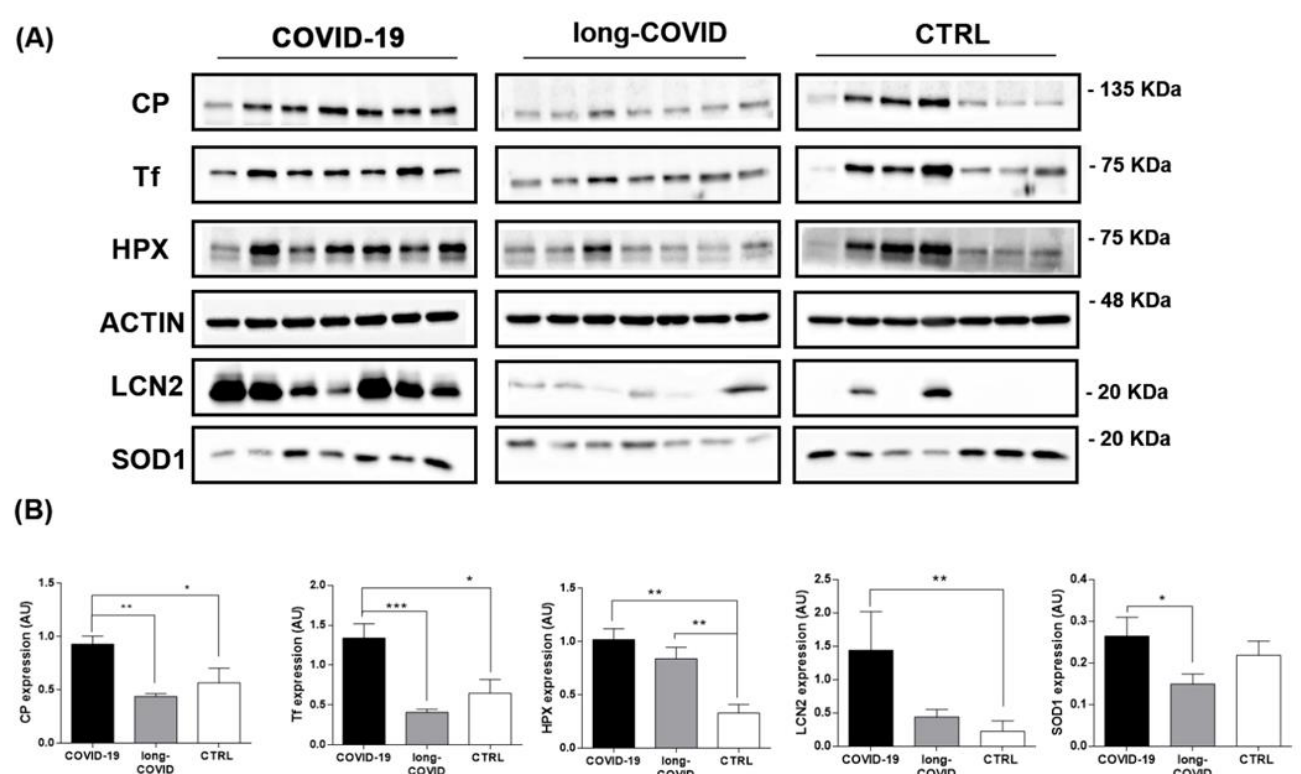
Figure 2. Western blot analysis for iron-related proteins in PBMCs isolated from COVID-19, long- COVID patients, and healthy controls. ( A ) Panels report the proteins levels for CP, Tf, HPX, LCN2, SOD1 and ACTIN in PBMCs isolated from COVID-19 patients (n = 7), long-COVID (n = 7) patients, and healthy volunteer donors (n = 7). ( B ) Band intensities were quantified using Image J and are reported in the figure as arbitrary units (AU). Data reported in this figure are the mean ± SE of two independent experiments (* p < 0.1, ** p < 0.01, *** p <